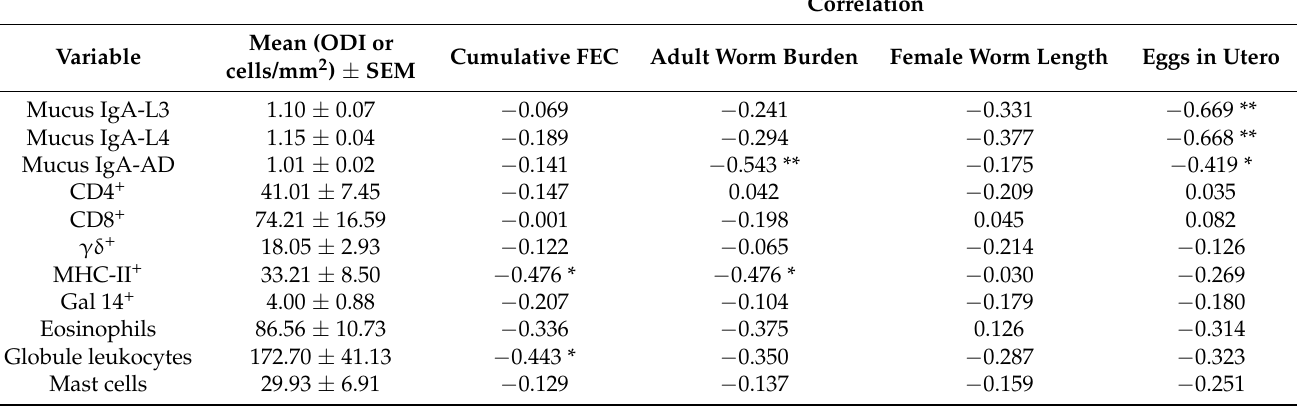
Table 3. Immunological means and correlations in three-month-old sheep after trickle infection with Teladorsagia circumcincta L3. Values are shown as mean Optical Density Index (ODI) for IgA expression or cells/mm 2 for cell recruitment ( n =